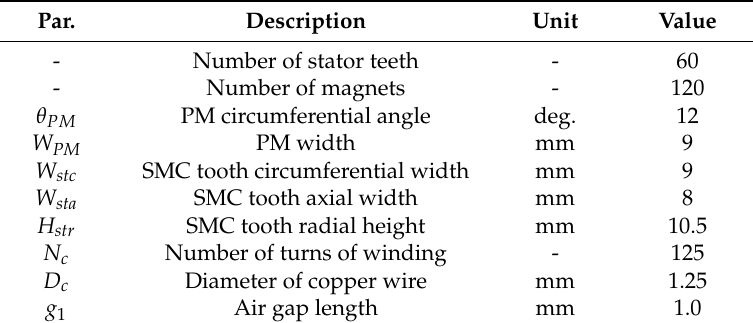
Figure 13. Structure of a PM-SMC TFM ( a ) and a prototype of the SMC stator ( b ). Table 7. Main dimensions and parameters for the